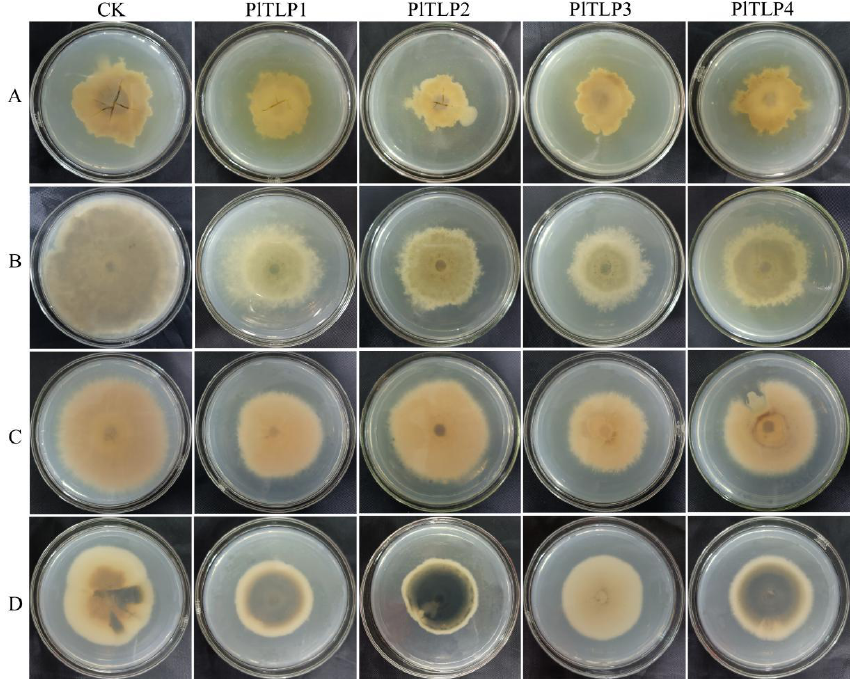
Figure 6. Inhibition of fungi growth by recombinant PlTLP proteins. ( A ) L. piceae . ( B ) B. cinerea . ( C ) F. proliferatum . ( D ) R. doimaesalongensis . CK: without recombinant PlTLP proteins. PlTLP1–4: 1 nmol of recombinant protein.